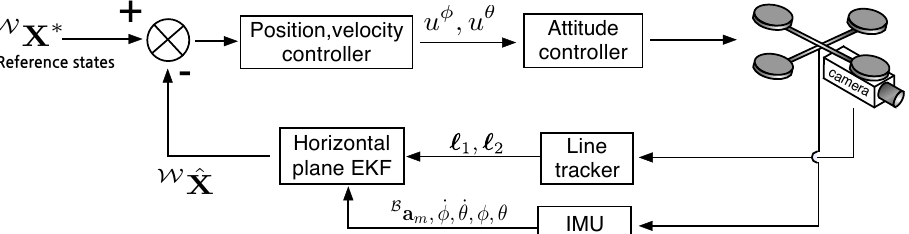
Figure 6. Block diagram of horizontal plane state estimator and control used for the PBVS approach. u φ and u θ denote control inputs for roll and pitch commands. (cid:96) 2D lines and B a is onboard inertial measurement unit (IMU) acceleration m